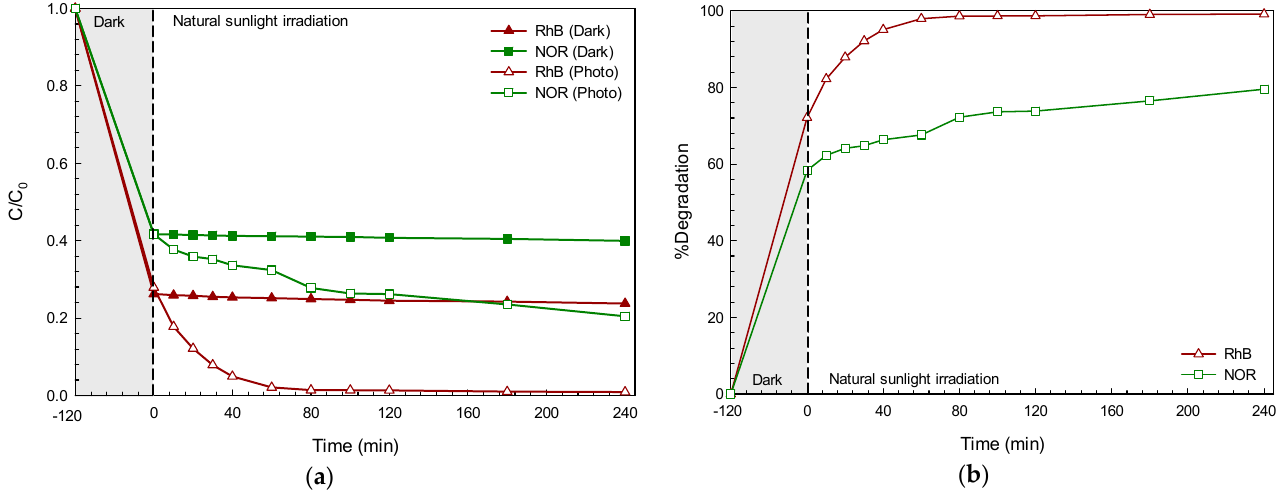
Figure 4. Plots of pollutant concentration (C/C 0 ) vs. time in the presence of BiOI photocatalyst under natural sunlight irradiation ( a ) and the corresponding photocatalytic efficiency ( b ).